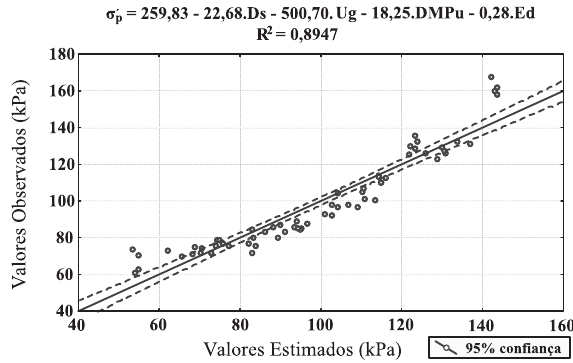
figura 6. modelo de tensão de pré-compactação (s ´ p ) em função da umidade gravimétrica (ug), do diâmetro médio ponderado dos agregados via úmida (dmpu), da quantidade de energia dissipada (ed) e da densidade do solo (ds). Valores estimados contra valores observados, na profundidade de 0–0,20 cm.